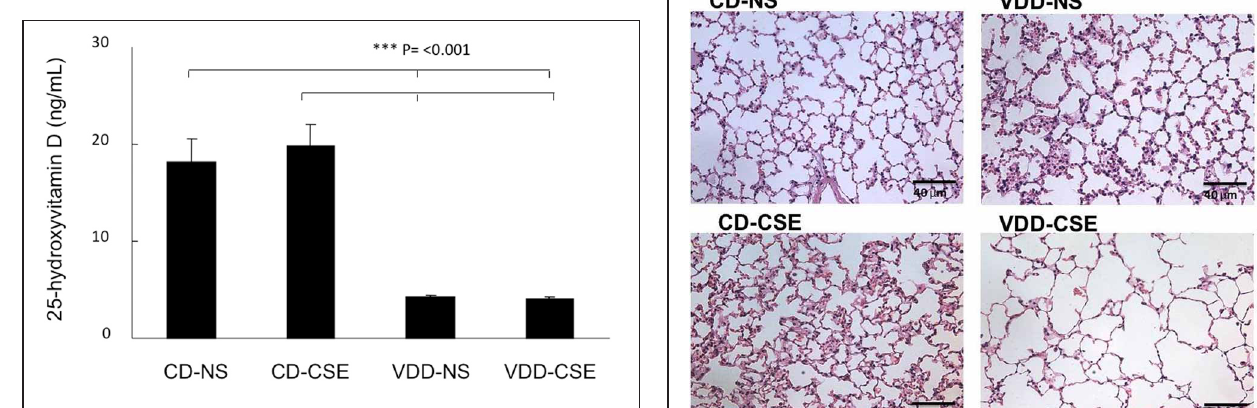
FIGURE 1 | 25-hydroxyvitamin D levels in the four treatment groups at the end of the experimental period. Values shown reflect means ± SEM of 19–23 mice per group. Levels of 25-hydroxyvitamin D in mice fed control diets were significantly different than mice fed a vitamin D deficient diet ( p = 0 . 001).